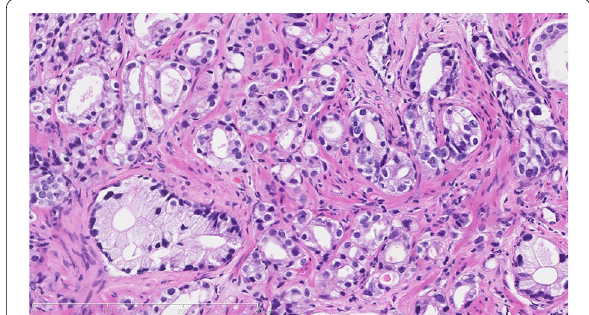
Fig. 1 Microscopically, the biopsied specimen was composed of eosinophilic tumor cells with oval nuclei, which exhibited fused microacinar gland pattern by hematoxylin–eosin (HE) staining. The Gleason score was 4 3 7 + =